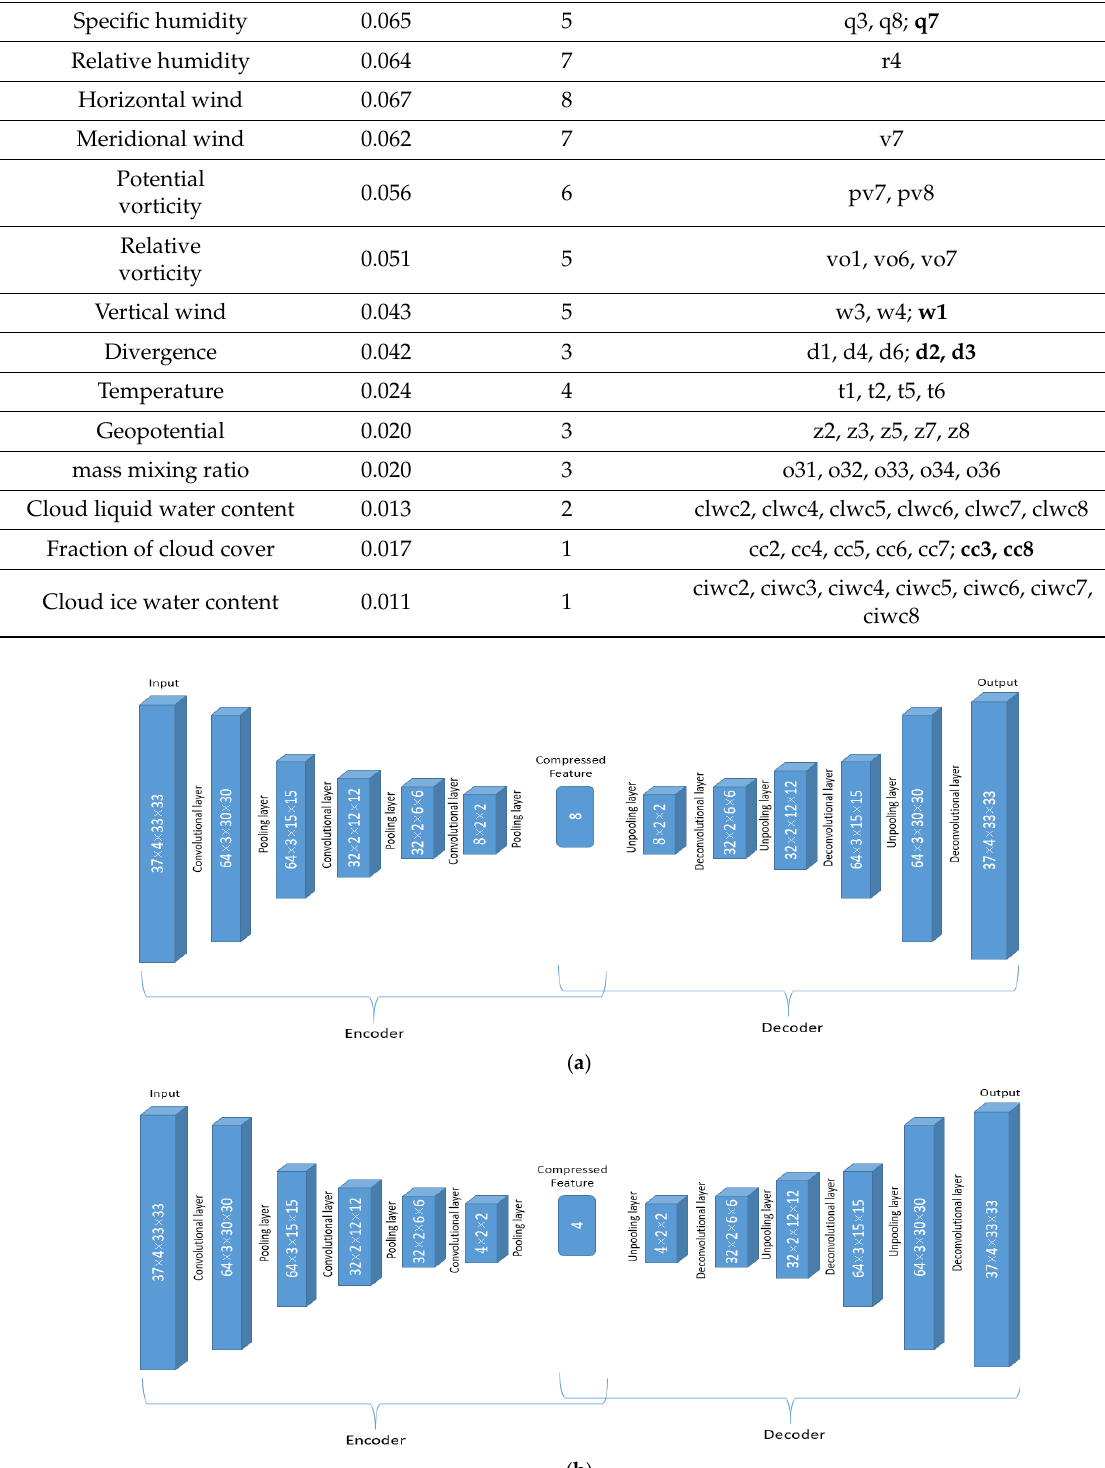
( c ) Figure 5. The structure for the adjusted auto-encoder network with the number of compressed features (num) as 8 ( a ), 4 ( b ), and 2 ( c ). After the new structures for DL Interim filters are derived, we retrain each network 200 times, although all the networks converge after 100 iterations. It should be emphasized that the randomness in the TCNET training process makes the training results different for different training sessions. However, the overall trends in the results should be similar if not the same. As same as being processed above, 19 variables, i.e., pv2, pv4, pv5, q1, u4, u7, v1, v2, vo2, vo7, w4, d1, d2, d4, t2, t3, t4, z1, and o32 are zero features, i.e., they contain